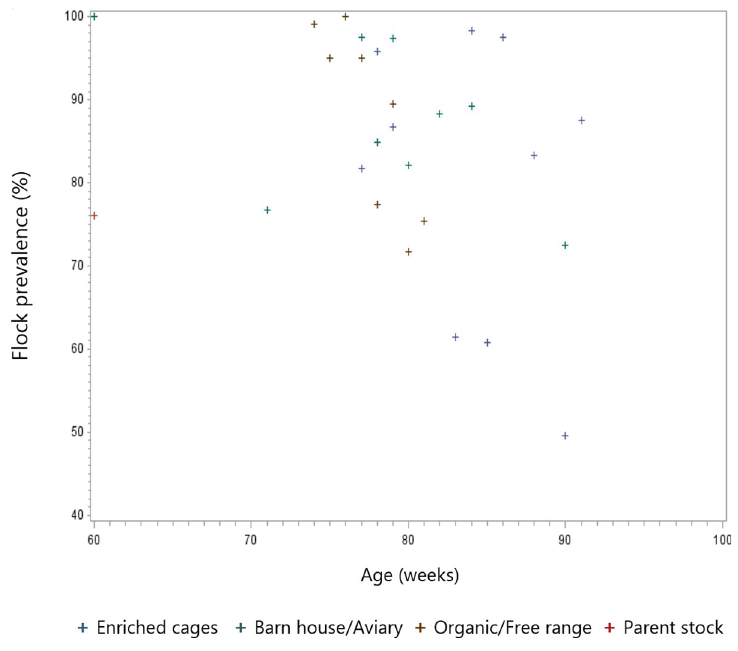
Fig 6. Scatter plot of the flock prevalence in relation to the flock age at